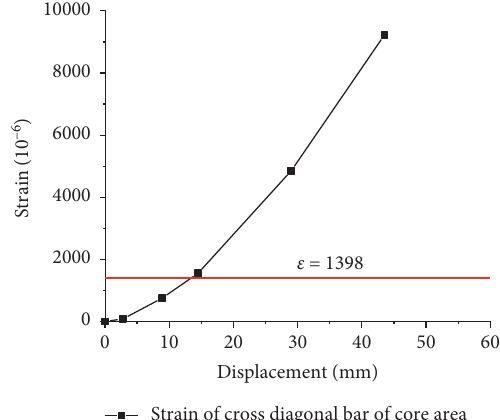
Figure 18: Strain of cross diagonal bar of the core area.